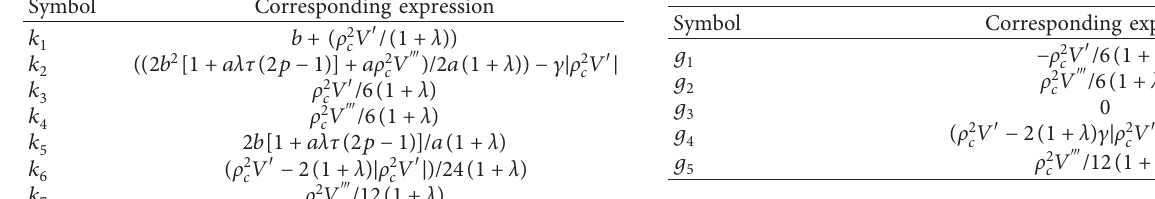
Table 2: The coefficients g